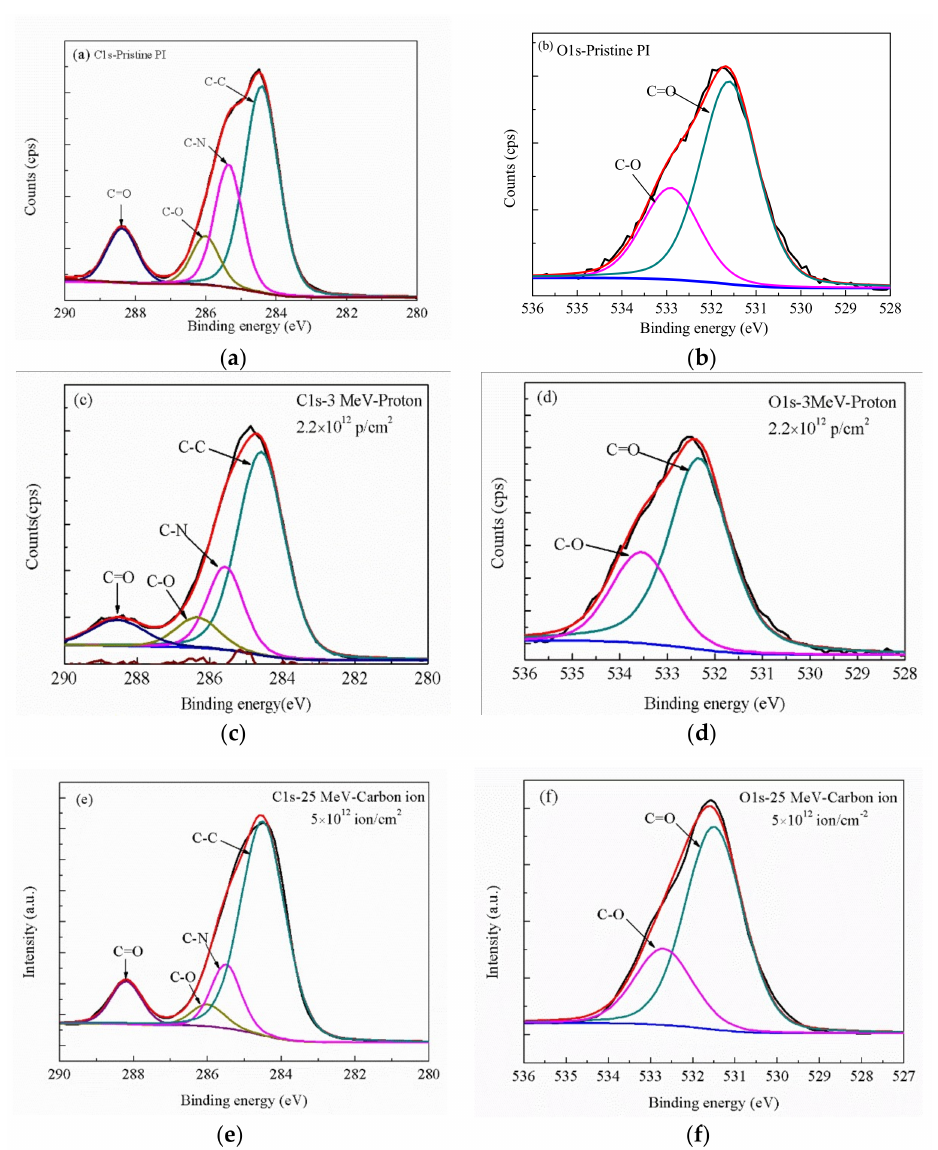
Figure 4. X-ray photoelectron spectroscopy (XPS) curves of pristine and irradiated PI films: ( a ) C1 s of pristine PI, ( b ) O1 s of pristine PI, ( c ) C1 s of irradiated PI with 3 MeV proton of 2.2 × 10 12 p / cm 2 , ( d ) O1 s of irradiated PI with 3 MeV proton of 2.2 × 10 12 p / cm 2 , ( e ) C1 s of irradiated PI with 25 MeV carbon ion of 5 × 10 12 p / cm 2 , and ( f ) O1 s of irradiated PI with 25 MeV carbon ion of 5 × 10 12 p / cm 2